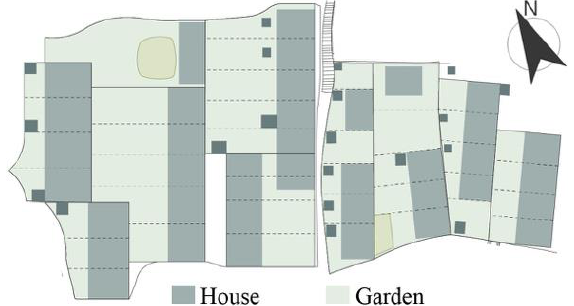
Figure 2. Detailed distribution of houses and open-air areas. Plan view (Authors).